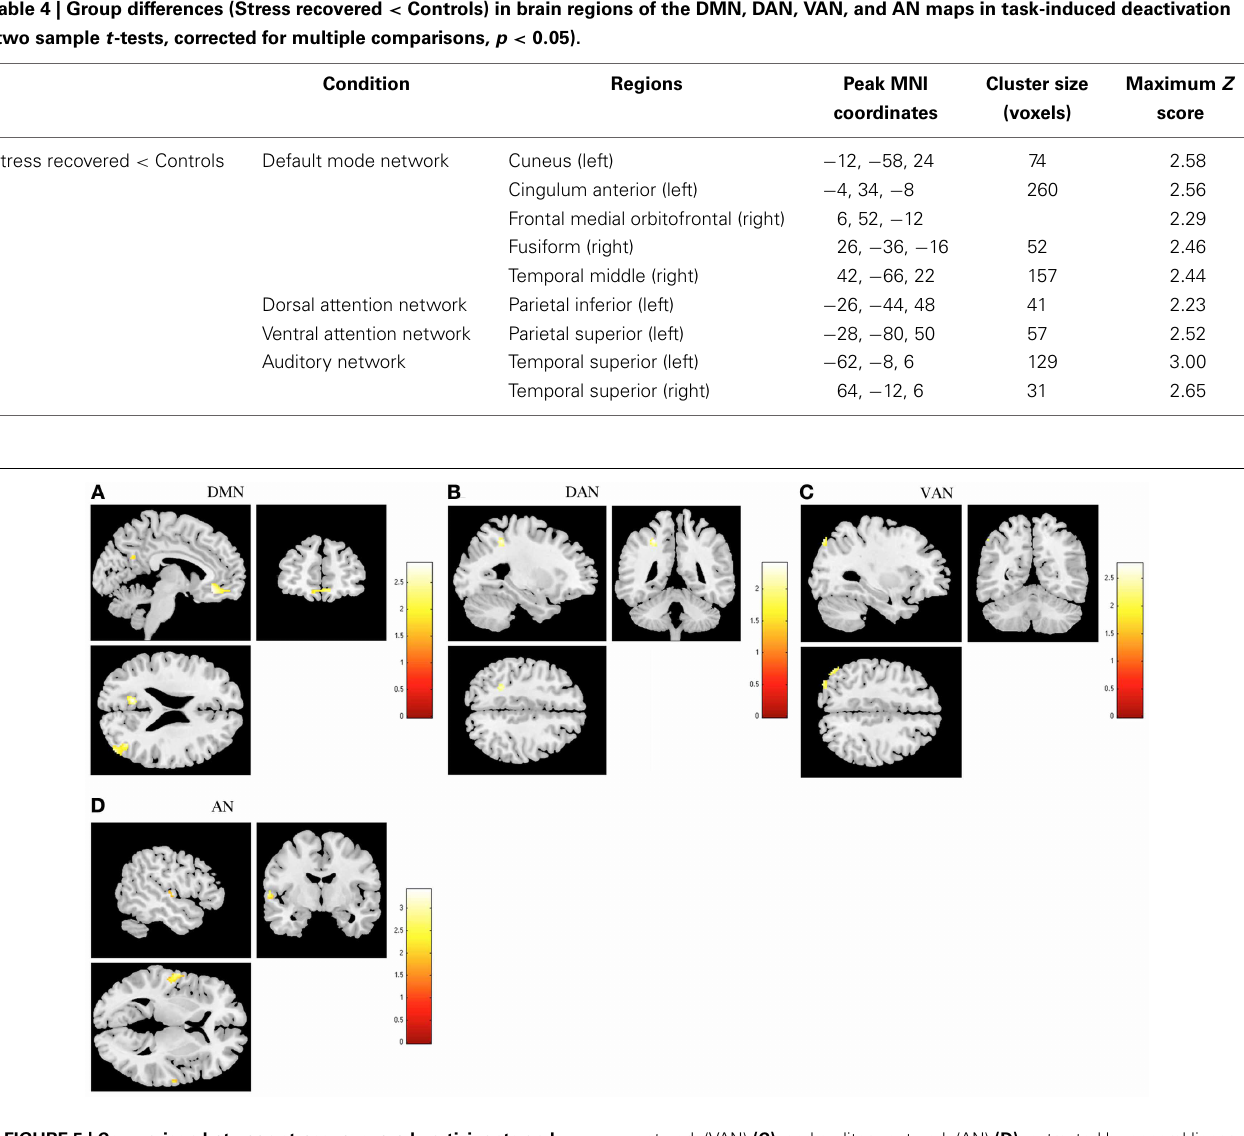
network (VAN) (C) , and auditory network (AN) (D) , extracted by general linear model analysis and using two-sample t -tests, with results considered significant at a corrected for multiple comparisons p < 0 . 05 threshold. Importantly, no areas of increased deactivation of these RSNs were found in stress recovered when compared to controls